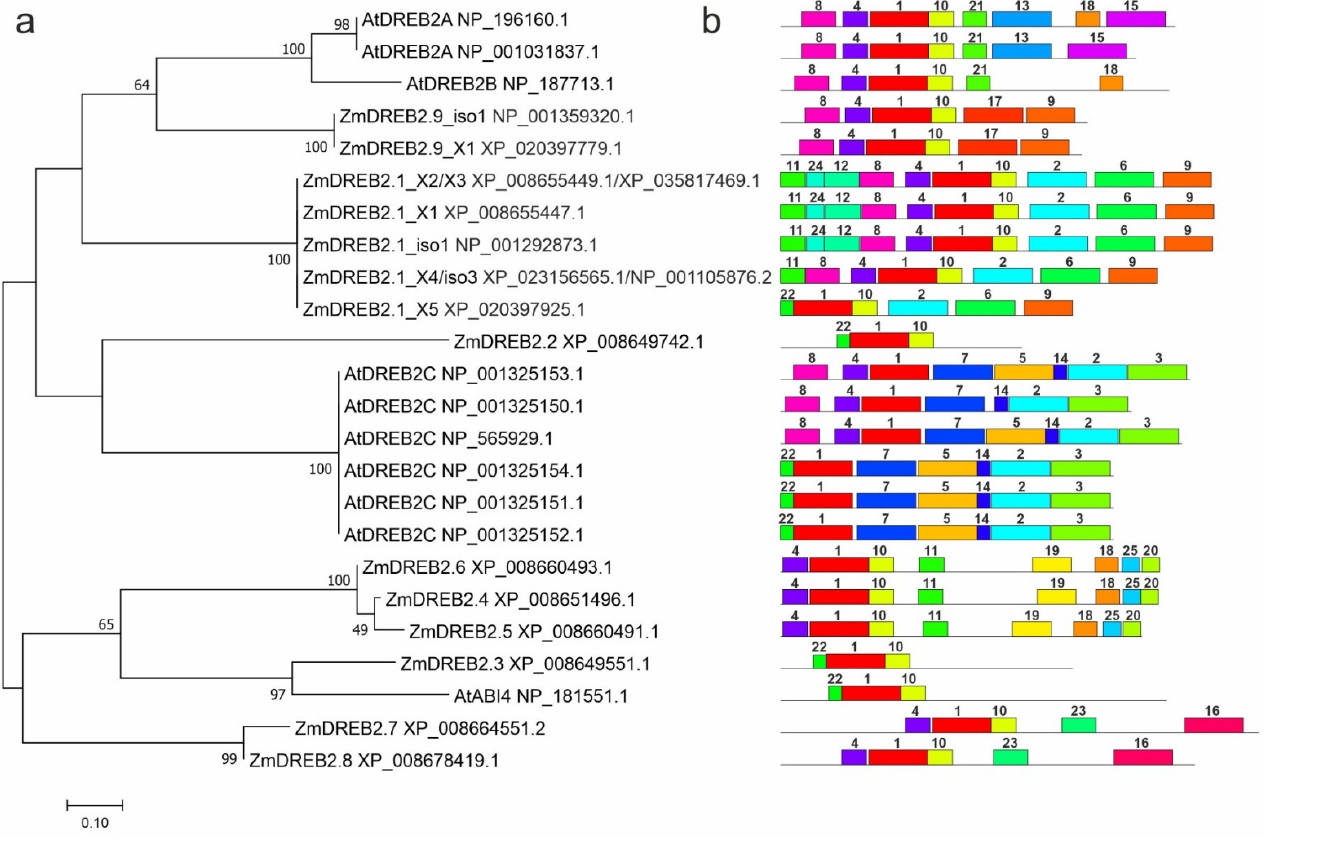
Figure 2. Evolutionary relationships of the ZmDREB2.1/2A–2.9 and A. thaliana AtDREB proteins (NCBI IDs are indicated). ( a ) The unrooted dendrogram was constructed using the Maximum Likelihood method according to the JTT matrix-based model (bootstrap test: 1000 replicates) in MEGA 7.0.26. ( b ) Distribution of conserved motifs in ZmDREB2.1/2A–2.9 and AtDREB proteins. Analysis was performed using MEME 5.4.1; the length of each box corresponds to that of the motif.